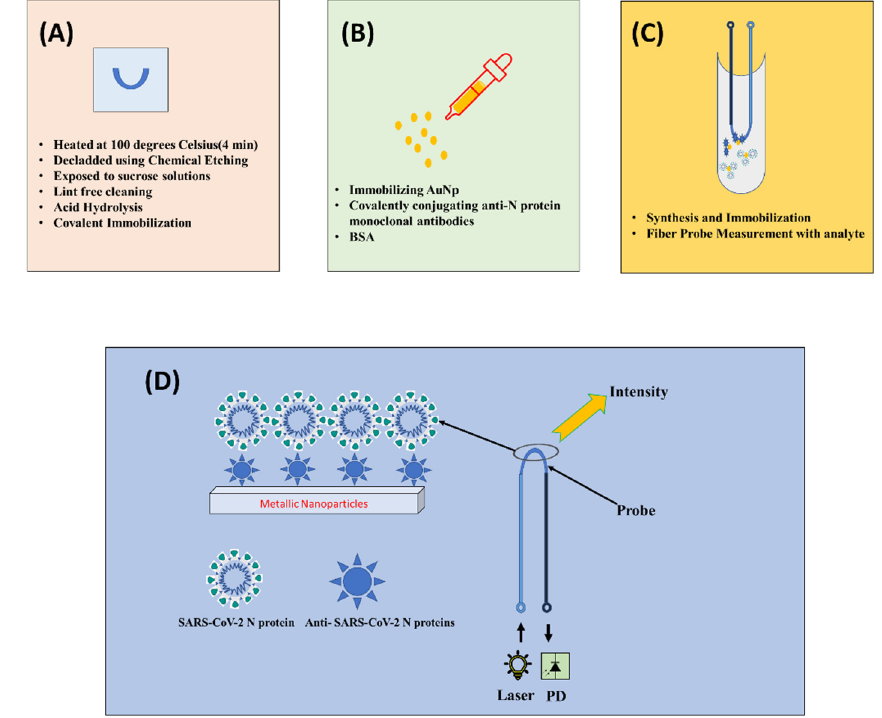
Figure 4. Block diagram of U-shaped fiber-optic sensing for SARS-CoV-2 detection general steps that are followed. ( A ) presents creation of U-shaped fiber; ( B ) represents functionality activation of U-shaped fiber probe; ( C ) represents metallic nanoparticles synthesis and immobilization and ( D ) presents the overall methodology for fiber-optic sensing for SARS-CoV-2 detection.